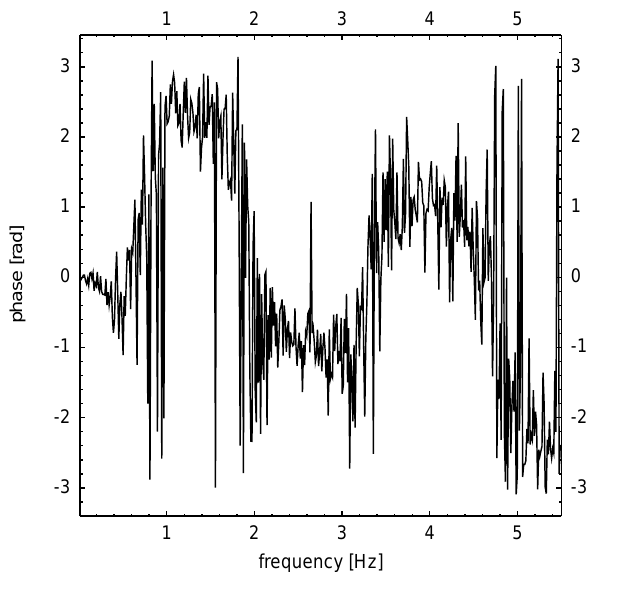
Fig. 7. Phase of the Fourier cross-spectrum for a pair of nonstation- ary test signals.